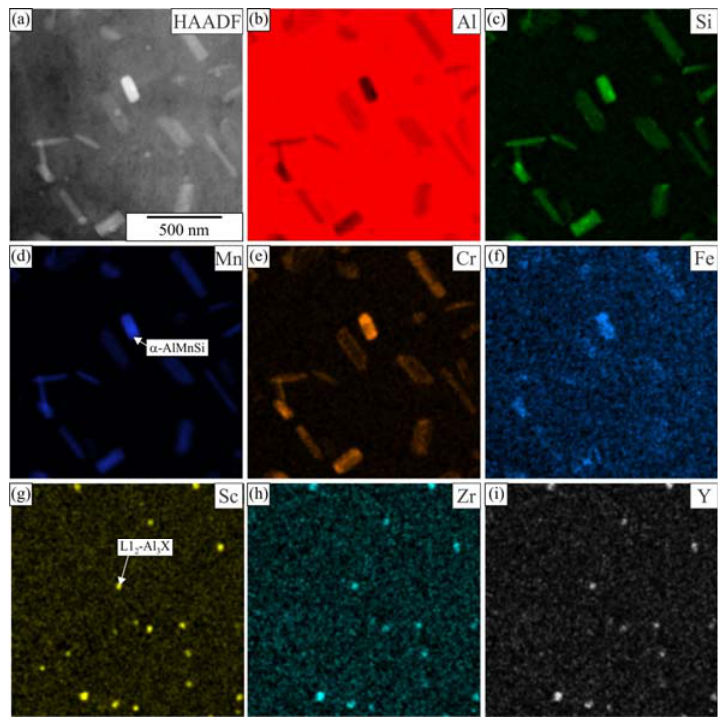
Figure 14. Distribution of the elements within the matrix of the alloy 6086-ScY after homogenization and holding for 5 h at 400 °C. ( a ) HAADF micrograph, EDS mapping of selected elements ( b ) Al, ( c ) Si, ( d ) Mn, ( e ) Cr, ( f ) Fe, ( g ) Sc, ( h ) Zr, and ( i ) Y.